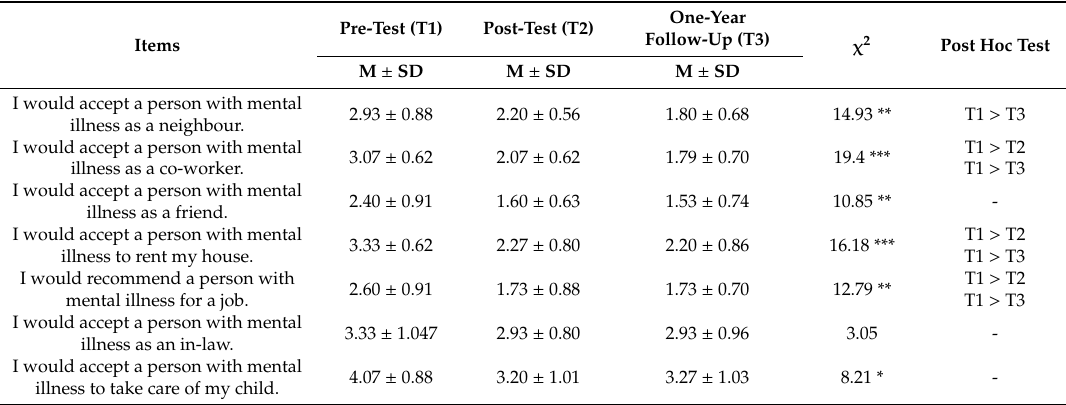
Table 3. The results of Friedman test on the pre-test, post-test, and follow-up scores for the Social Distance Scale among students who completed the course ( n =